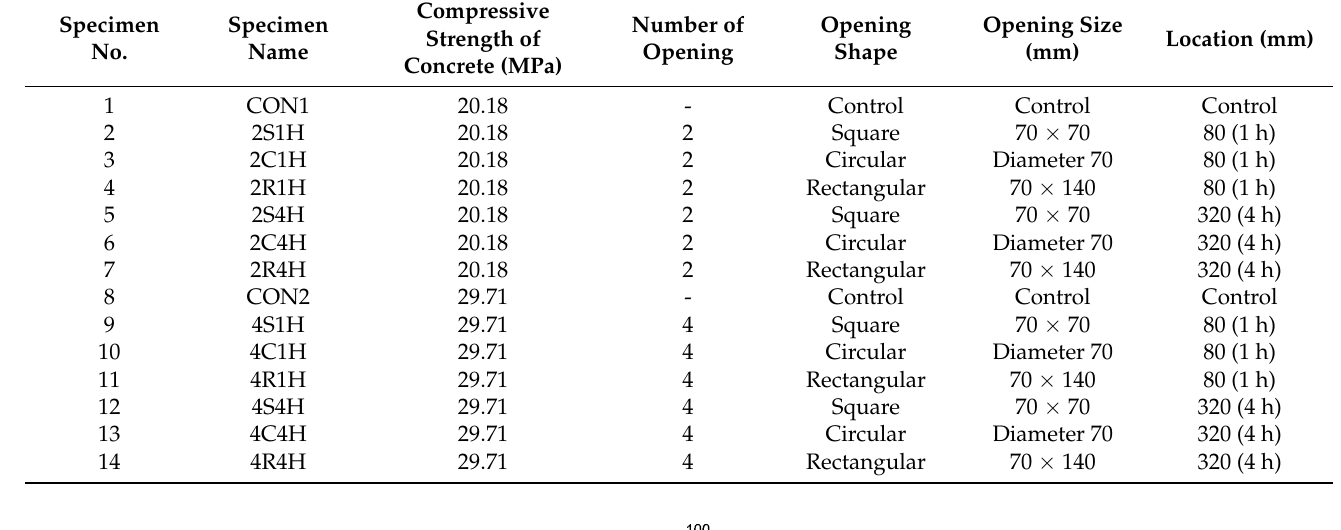
Table 1. Test Matrix.